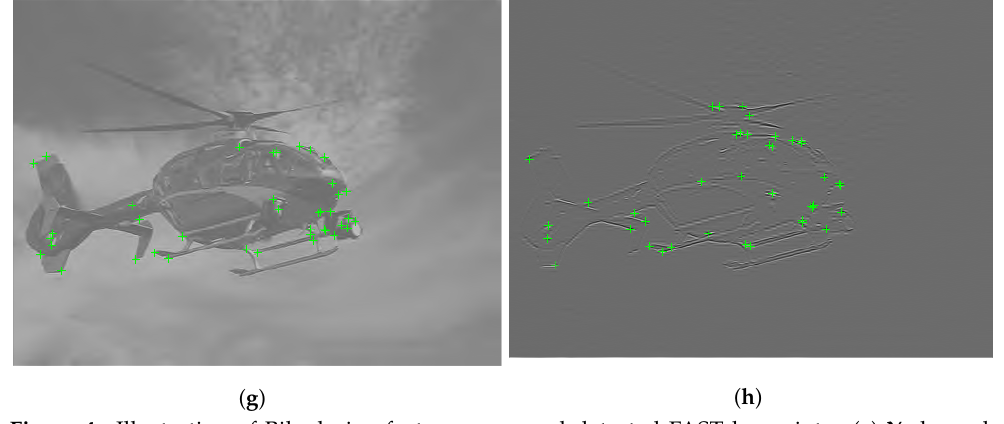
Figure 4. Illustration of Bilaplacian feature maps and detected FAST keypoints. ( a ) Y channel,